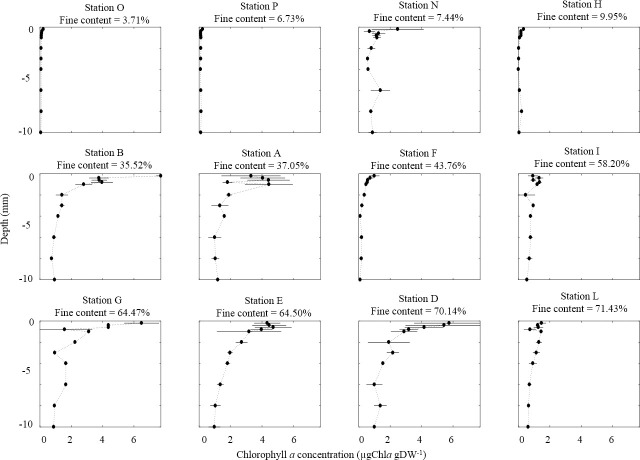
Vertical depth profile of chl a (μg gDW-1) at each sampling site in April 2015.Horizontal bars represent the standard deviation (n = 3).